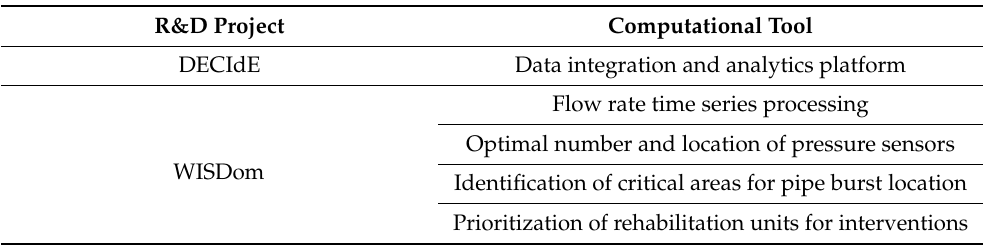
Table 1. Computational tools developed under the scope of the DECIdE and WISDom R&D